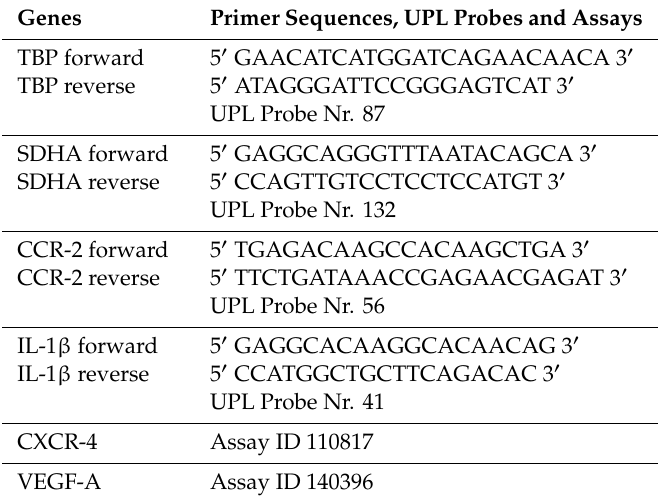
Table 2. Primer sequences, UPL Probes, and Real Time Ready Single Assays used in qPCR. Genes Primer Sequences, UPL Probes and